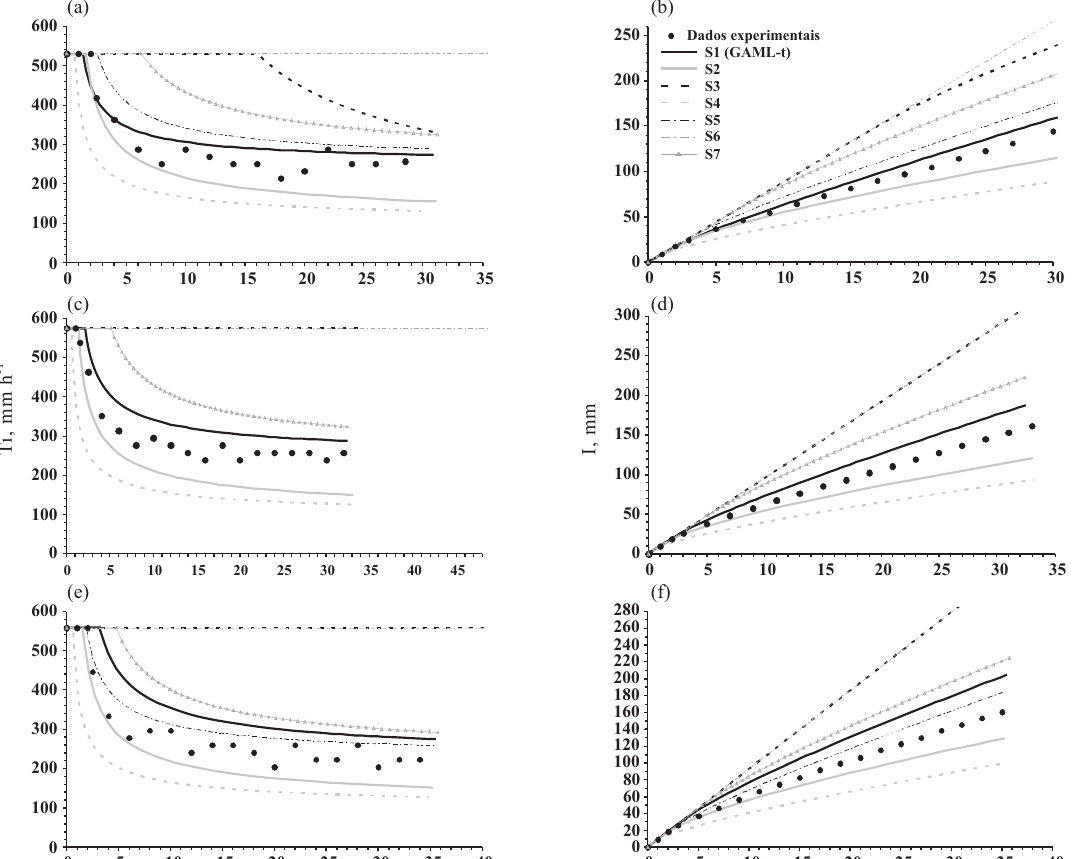
Figura 3. Taxas de infiltração (a), (c) e (e) e lâminas infiltradas (b), (d) e (f) medidas e estimadas para os três testes experimentais realizados no